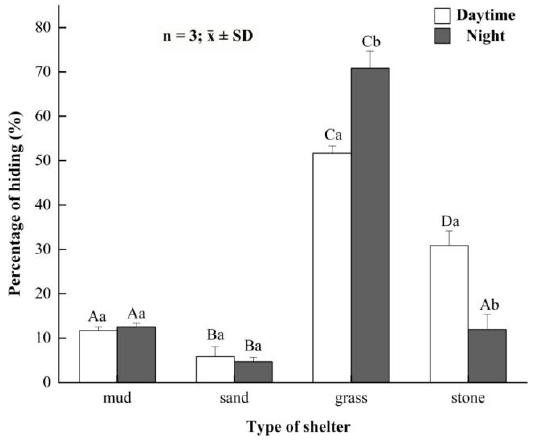
Figure 4. The hiding rate of juvenile Eriocheir sinensis in different shelters between daytime and night. Bars with same letters on the top indicate they have insignificant differences ( p > 0.05), and bars with different letters on the top indicate they have significant differences ( p < 0.05). Capital letters indicate the significance of hiding rates in different developmental stages, and lowercase letters indicate the significance of hiding and not hiding in the same